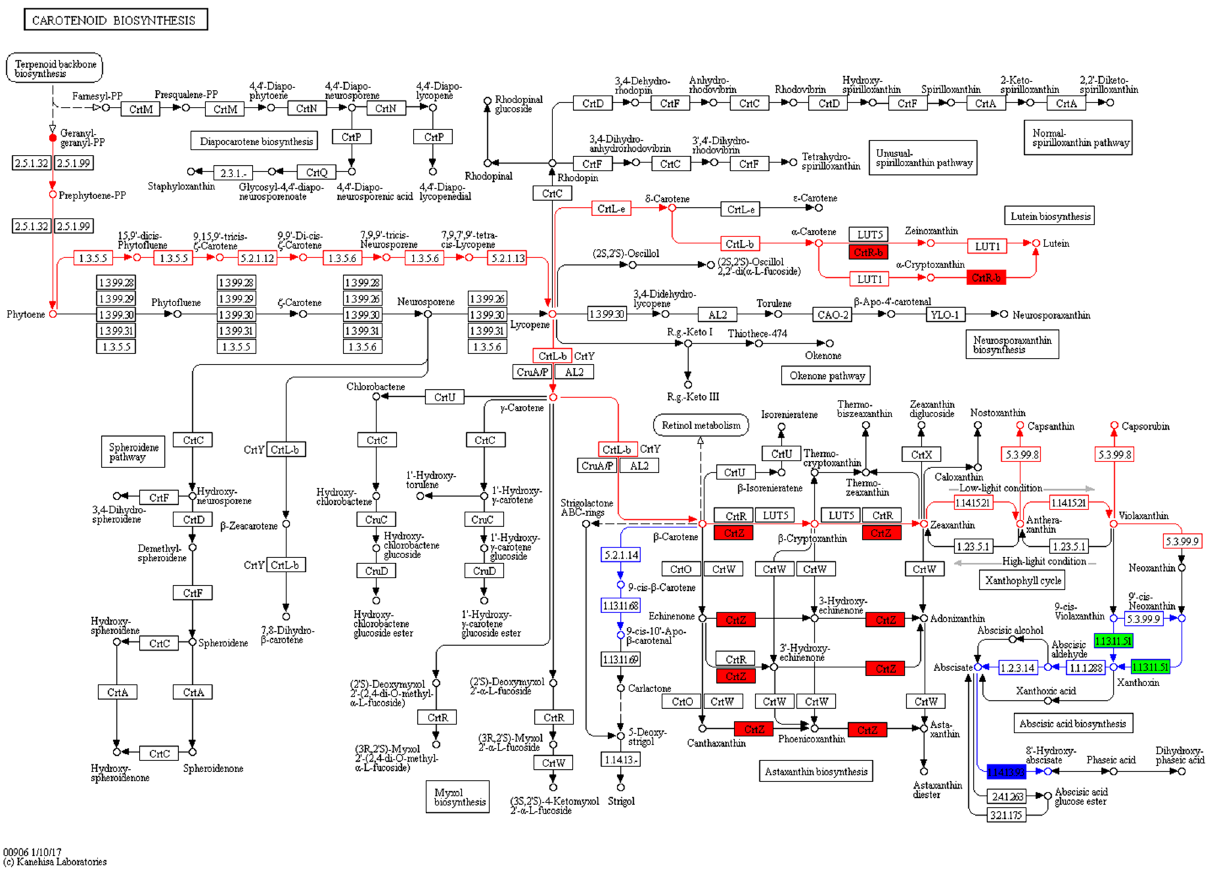
Figure 4. Carotenoid metabolism. Biosynthesis process is marked in red and the catabolism is labeled in blue. Using FC > 2 and FDR value ≤ 0.001 as the selection criteria to analyze the enrichment of